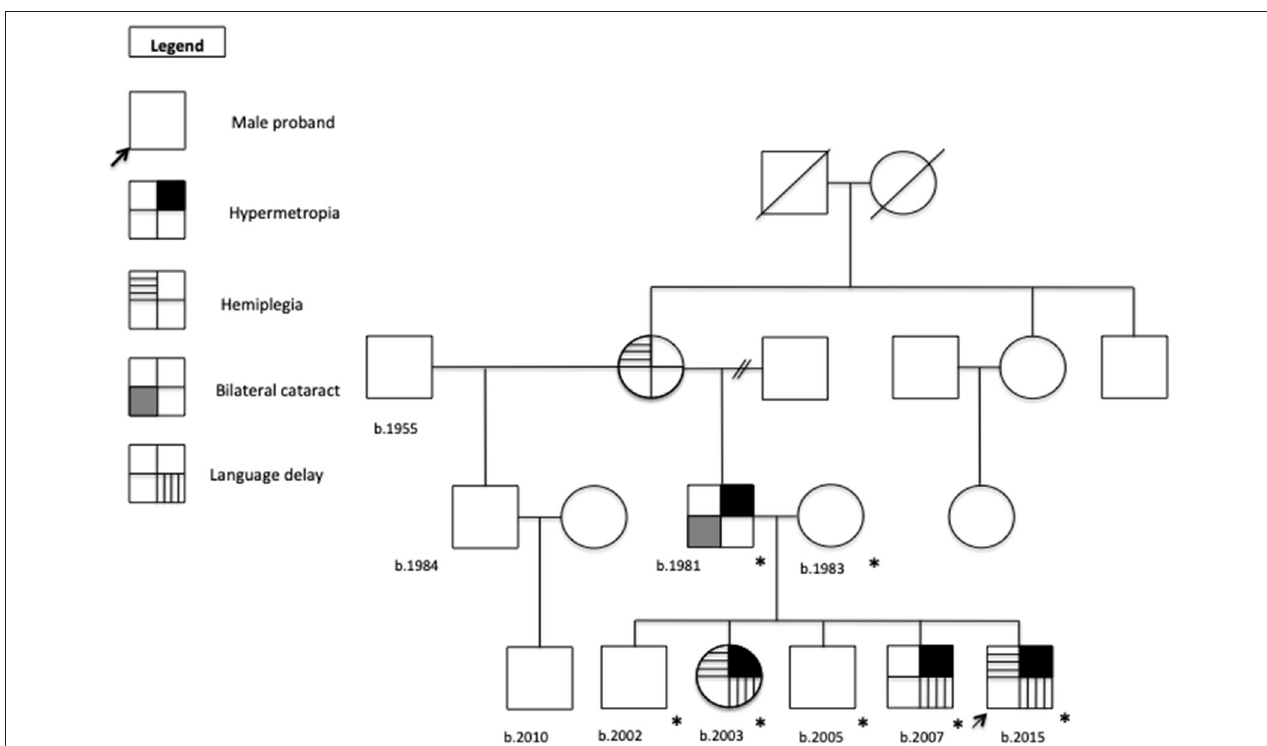
FIGURE 1 | Familial